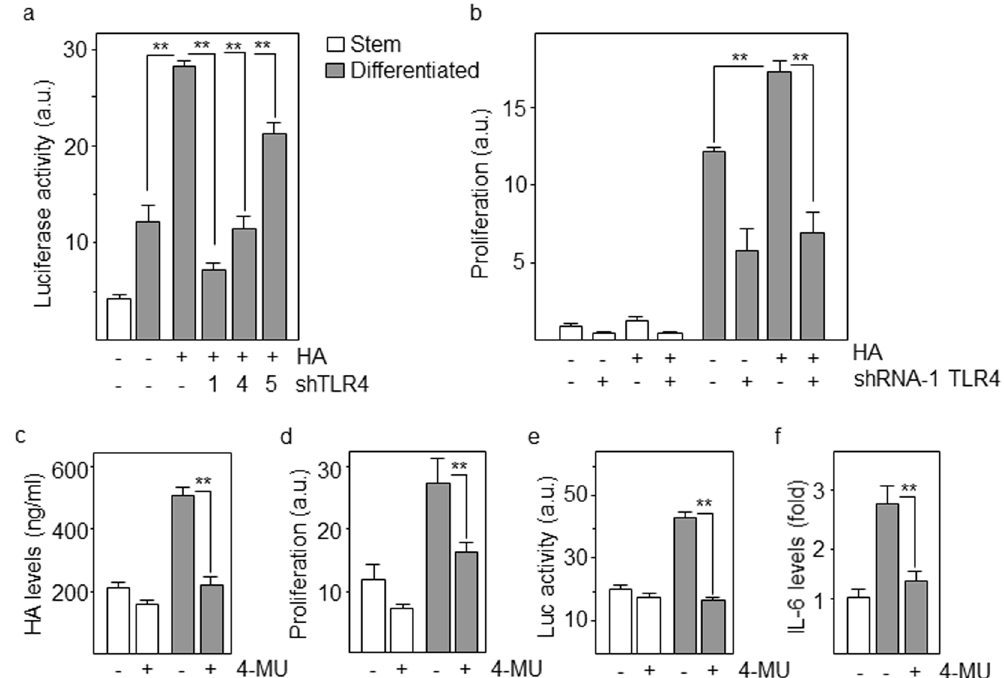
Figure 6. Hyaluronic acid triggers TLR4 signaling in differentiating GSCs. ( a ) Cells were cotransfected with the NF κ B-luciferase reporter vector and TLR4-specific or control shRNAs in the presence or in the absence of hyaluronic acid (HA). Luciferase activity was determined after 48 h of incubation under stem or differentiation conditions. ( b ) Proliferation of cells in the presence of HA following downregulation of TLR4 as determined by Alamar blue. ( c ) HA levels present in the culture medium of stem and differentiating cells treated with the HA synthesis inhibitor, 4-MU by ELISA. ( d ) Proliferation of stem and differentiating cells following treatment with 4-MU. ( e ) Luciferase activity of cells transfected with the NF κ B-reporter vector and treated with 4-MU. ( f ) Expression levels of IL-6 mRNA in differentiating GSCs treated with 4-MU by quantitative RT- PCR. Histograms represent the mean ± SD of three independent experiments. Asterisks represent significant differences ( ** p < 0.01). a.u., arbitrary